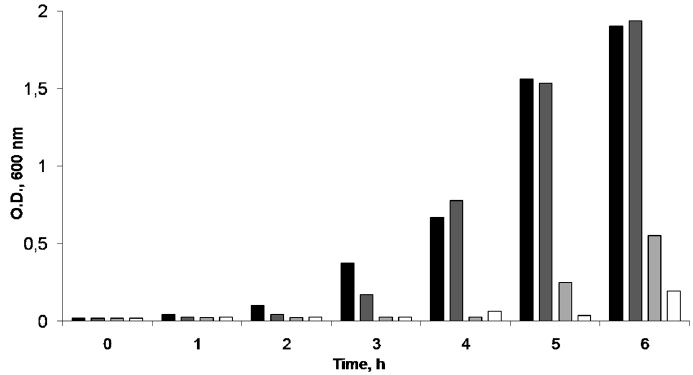
Figure 8. E. coli growth inhibition for different Ag concentrations. Ag 0 ppm ( ■ ); Ag 1.32 ppm ( ■ ); Ag 3.76 ppm ( ■ ); Ag 6.26 ppm ( □ ).